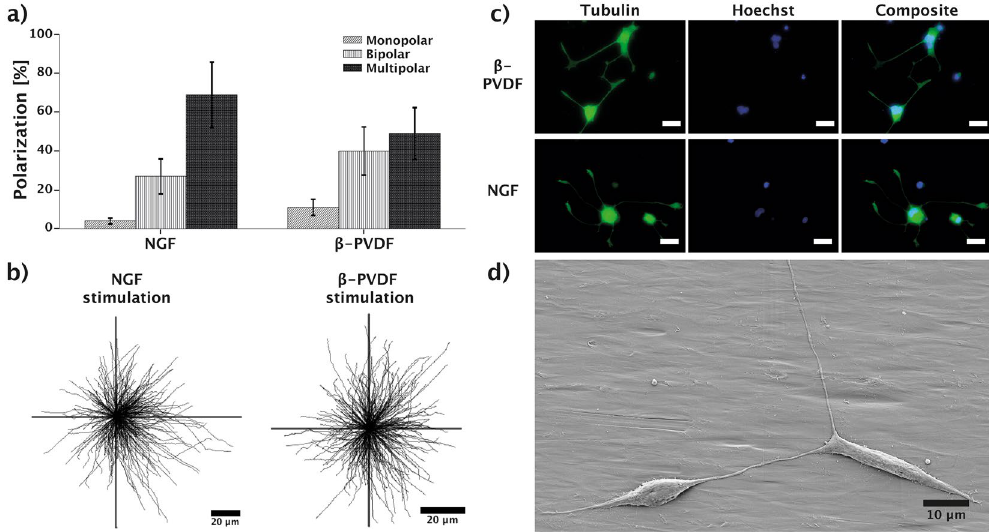
Figure 3. ( a ) Polarization of differentiated PC12 cells stimulated by NGF or β -PVDF/US. ( b ) Tracing of the measured neurites, showing their length and directionality. ( c ) Fluorescence images of stained tubulin (green) and nucleus (blue), differentiated PC12 cells stimulated by β -PVDF/US or NGF; scale bar represents 10 μ m. ( d ) SEM image showing differentiated PC12 cells on the β -PVDF membrane after nine days of US